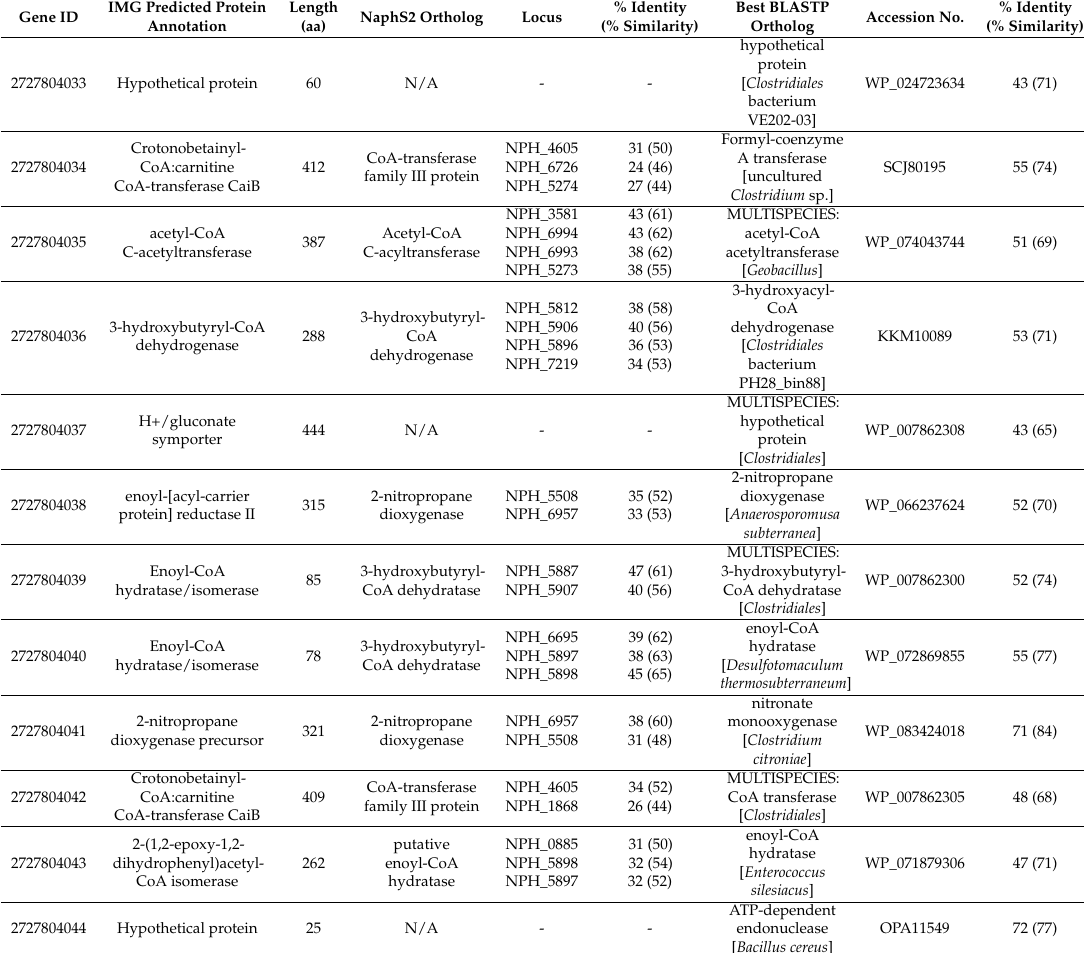
Table 3. Overview of binned Clostridiaceae Scaffold 1013. Percent sequence identity/similarity of protein-encoding encoding genes are compared to orthologous loci detected in the NaphS2 genome and within NCBI protein sequence